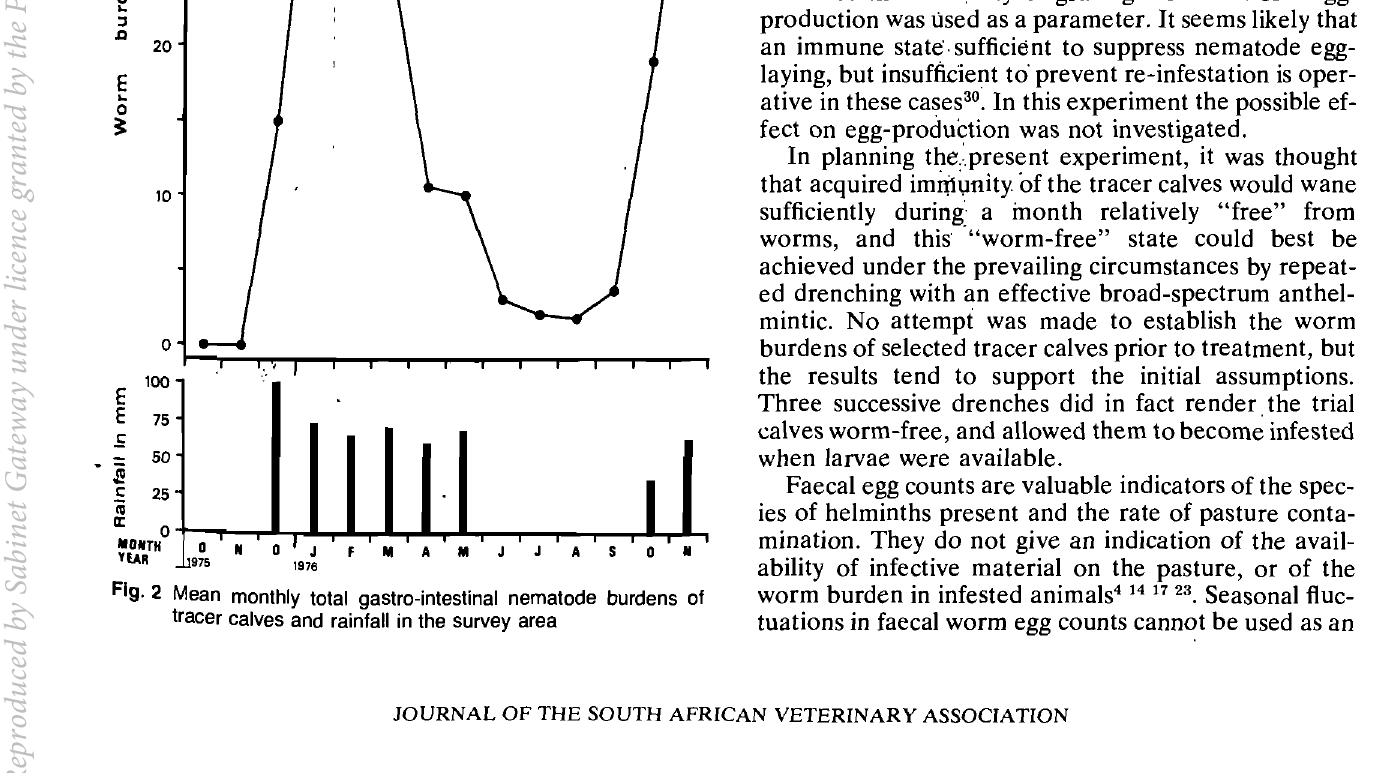
Fig. 2 Mean monthly total gastro-intestinal nematode burdens of tracer calves and rainfall in the survey